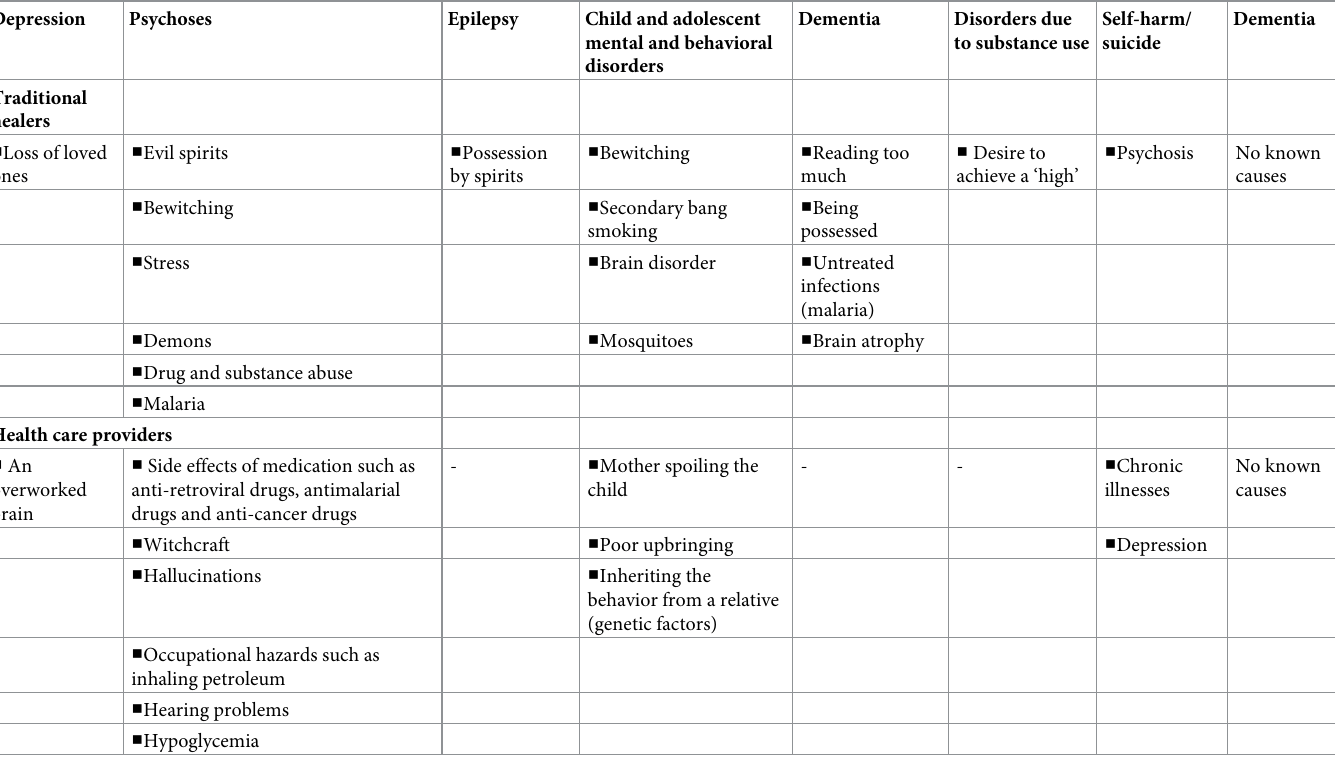
Table 2. Causes of mental